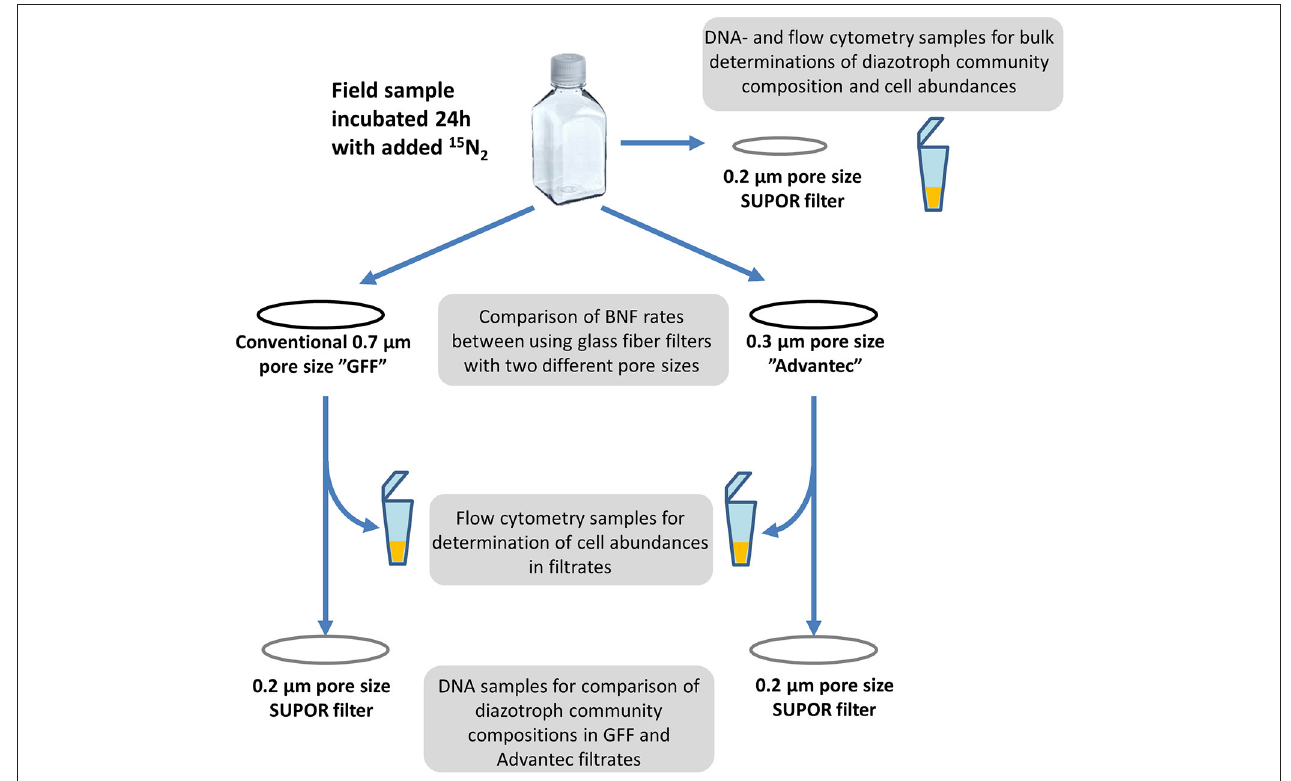
FIGURE 1 | Scheme illustrating the experimental setup for comparing GF/F and Advantec